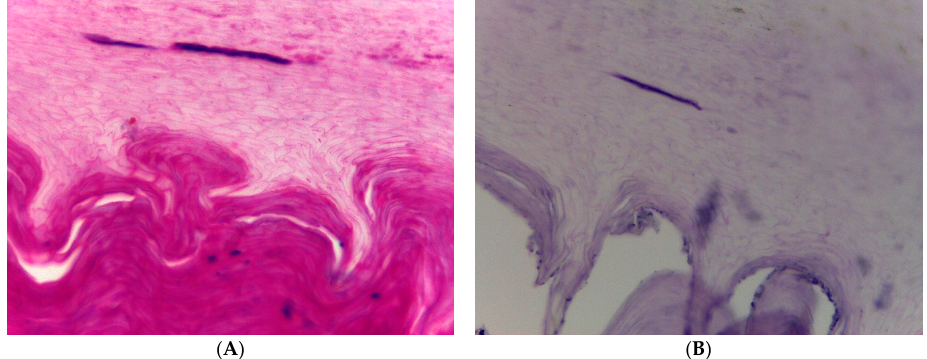
Figure 5. Histopathology of the nail clipping of a single-digit onychomycosis in a 43-year-old Tamil female suggestive of a non-dermatophyte onychomycosis. PAS stain, original magnification 400×.